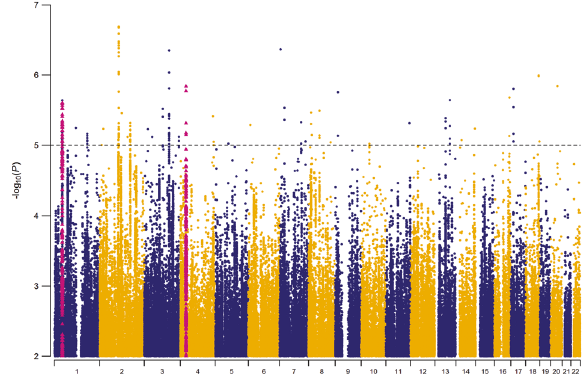
Fig. 1 Manhattan plot of overall meta-analysis for childhood aggression (AG Goverall ). Red triangles represent SNPs that were included in the signi fi cant genes from the gene-based analysis. SNPs for ST3GAL3 and IPO13 are included in the same locus on chromosome